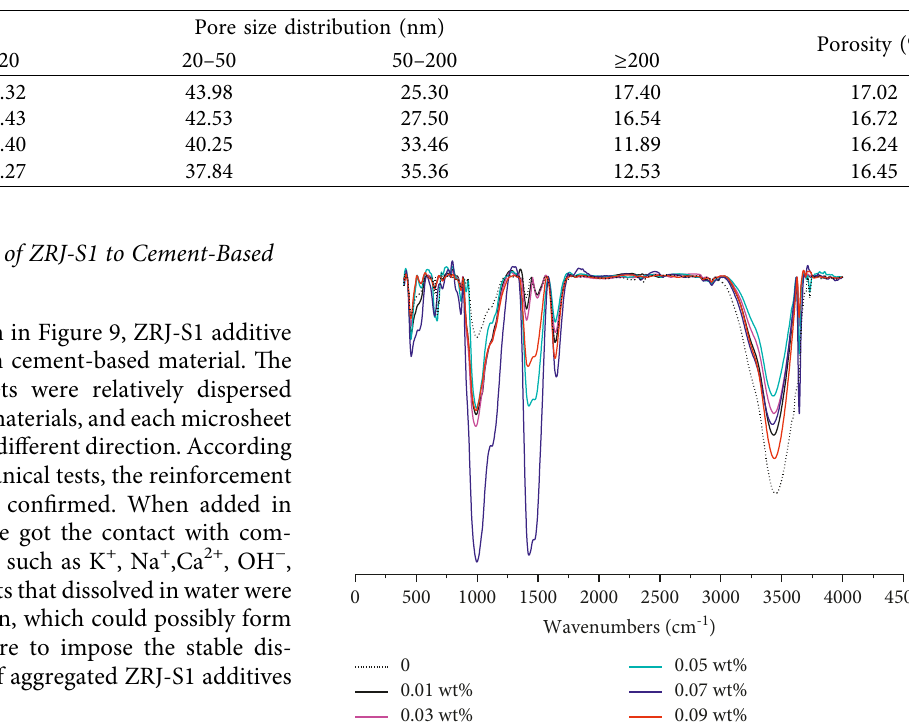
Table 8: Pore size distribution (%) and porosity (%).